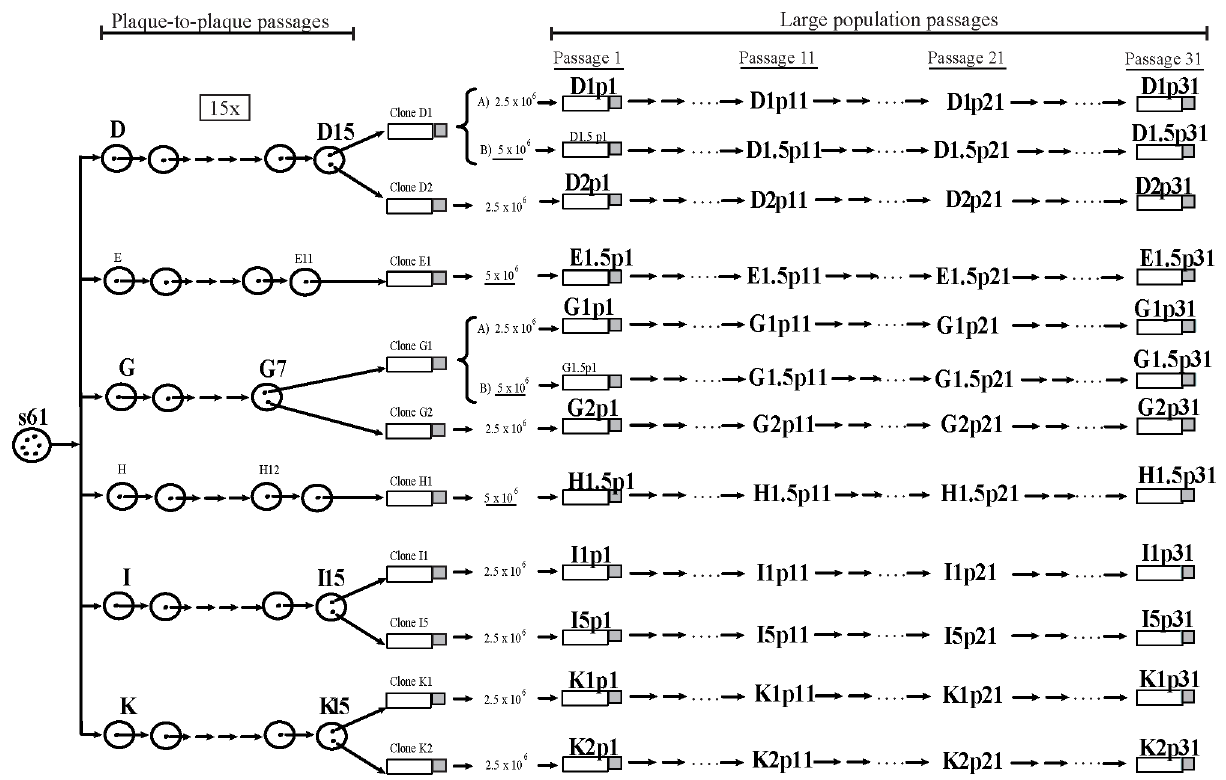
Figure 1. Genealogy of the HIV-1 viral clones studied. Schematic representation of the serial passages performed with the viruses. Six biological clones, derived from a natural isolate [3], represented by circles in the left part of the Figure, were plaque to plaque passaged for 15 rounds resulting in drastic fitness losses [4]. Some of the clones ( G , E and H ) did not overcame the 15 passages [4]. In general, two clones from the final debilitated biological clones designated D1 , D2 , E1 , G1 , G2 , H1 , I1 , I5 , K1 and K2 were later subjected to large population recovery passages [6]. Large population passages (10, 20 and 30) with these clones, represented by bottles, arrows and dots in the right part of the figure, were performed in 2.5 6 10 6 and 5 6 10 6 MT-4 cells [6]. Viral populations are indicated by letters identifying the clone, followed by p1 for the initial population, p11 for passage 11, p21 for passage 21 and p31 for passage 31 [6,7]. Clones D1 and G1 that are represented after keys were passaged in parallel in 2.5 6 10 6 (designated A) and in 5 6 10 6 MT-4 cells (designated B) [7]. Clones E1 , and H1 were passaged only in 5 6 10 6 MT-4 cells. The set of 55 viruses used in the present work are marked in bigger and bold font.